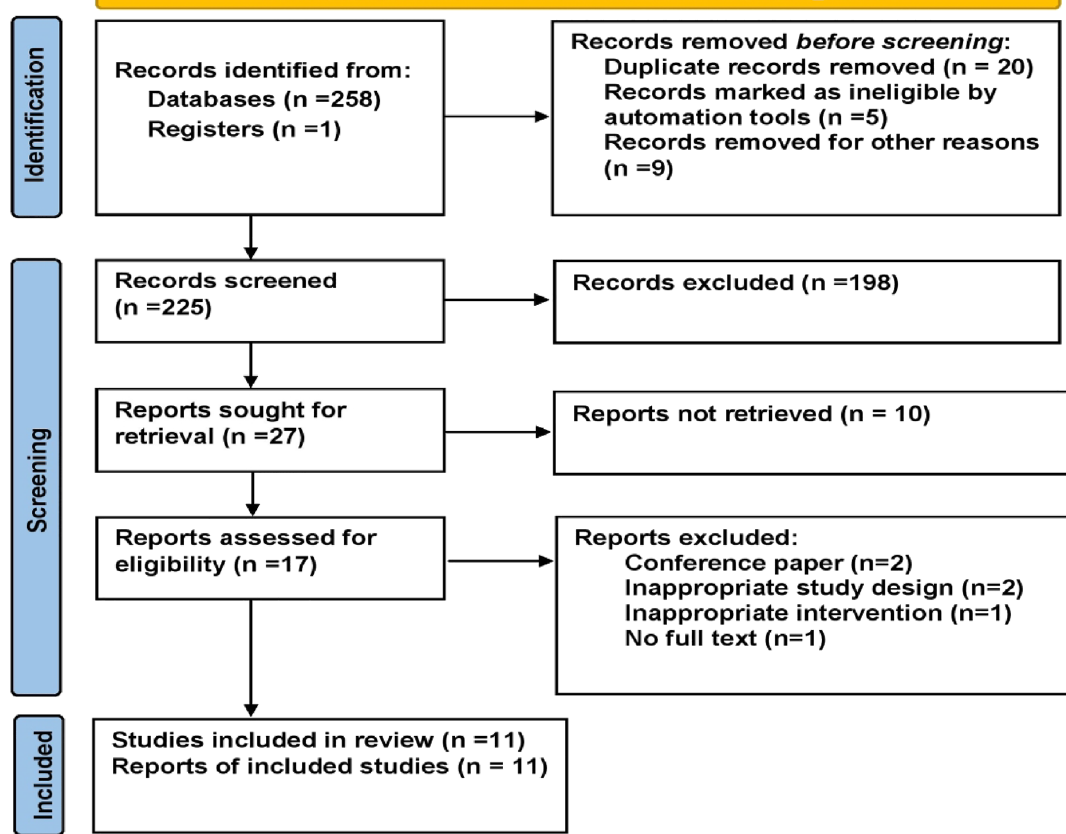
Figure 1. PRISMA flow chart summary of the systematic review search